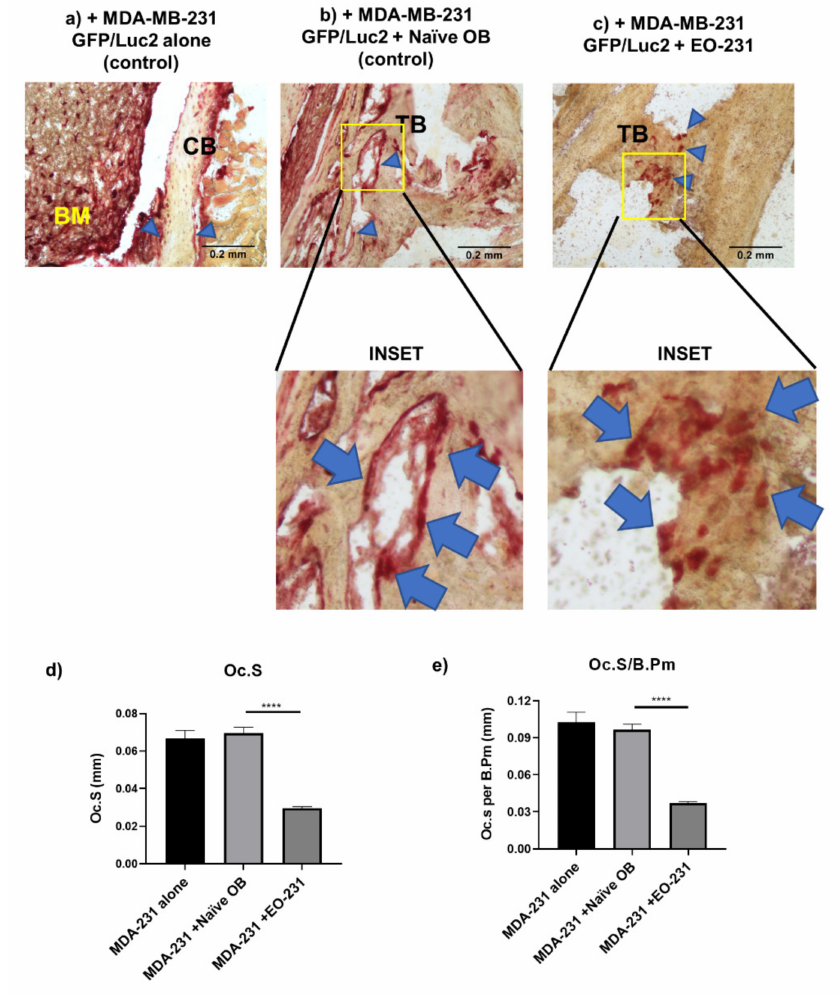
Figure 5. Increased Presence of EOs in Murine Bone Reduces Presence of TRAP-Positive Osteoclasts. Six-week-old female athymic nude mice were injected via the intratibial route with either one of the following: ( a ) human triple negative MDA-MB-231 GFP/Luc2 breast cancer cells alone (control); ( b ) naive osteoblasts plus human triple negative MDA-MB-231 GFP/Luc2 breast cancer cells (control); or ( c ) EO-231 cells plus human triple negative MDA-MB-231 GFP/Luc2 breast cancer cells. The mice were sacrificed eight weeks post-injection, when their tibiae were harvested, sectioned, then stained for the presence of tartrate-resistant acid phosphatase (TRAP; blue arrows), a common marker for mature osteoclasts. One representative image is displayed per condition. ( d ) The surface length (Oc.S) of TRAP-positive, mature osteoclasts were quantified for each condition. Additionally, ( e ) the surface size (Oc.S) of TRAP-positive, mature osteoclasts per bone perimeter (B.Pm) were quantified for each condition. Scale = 0.2. N > 5. mm = millimeter. BM, bone marrow; CB, cortical bone; TB, trabecular bone. **** p <